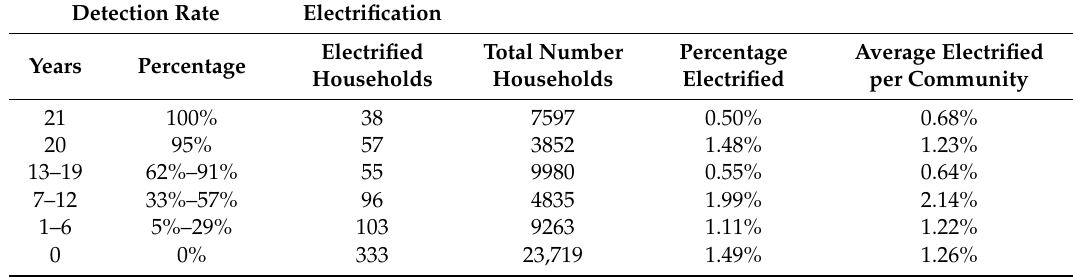
Table 3. Access to electricity of communities in Burkina Faso by detection rate in DMSP-OLS nighttime light